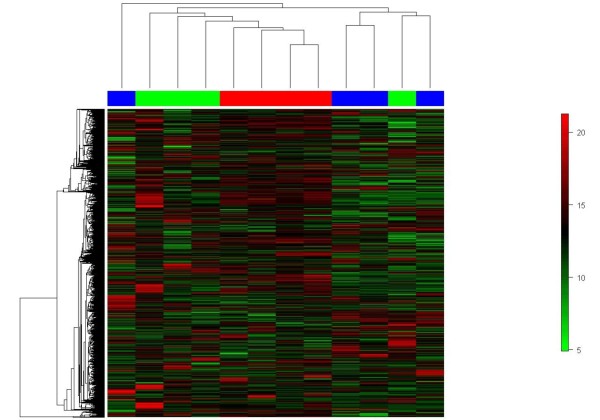
Unsupervised clustering of 4 follicular adenomas (FTA), 4 minimal invasive follicular carcinomas (FTC) and 4 widely invasive FTC. The clustering was performed with 3830 genes. Adenomas cluster to one group, which is surprisingly located between widely and minimal invasive follicular carcinomas. One of the widely as well as the minimal invasive follicular carcinoma is located in the each other group. Red: FTA, green: widely invasive FTC, blue: minimal invasive FTC